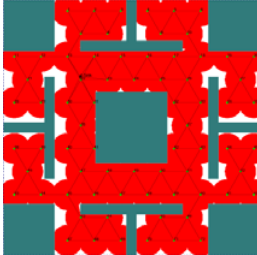
Figure 11. The sensing areas of Type 1 sensor nodes deployed with regular pattern in Case 1.